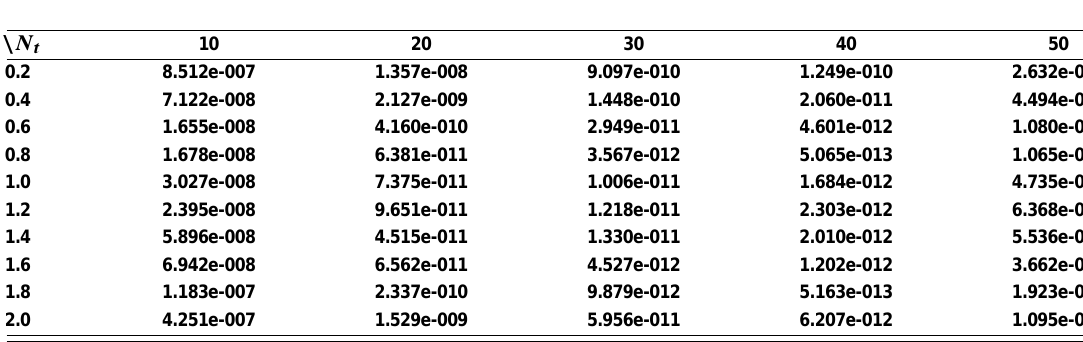
Table 2. Maximum errors E N for Burgers-Fisher equation when ˛ D (cid:13) D ı D 1 using N x D 30